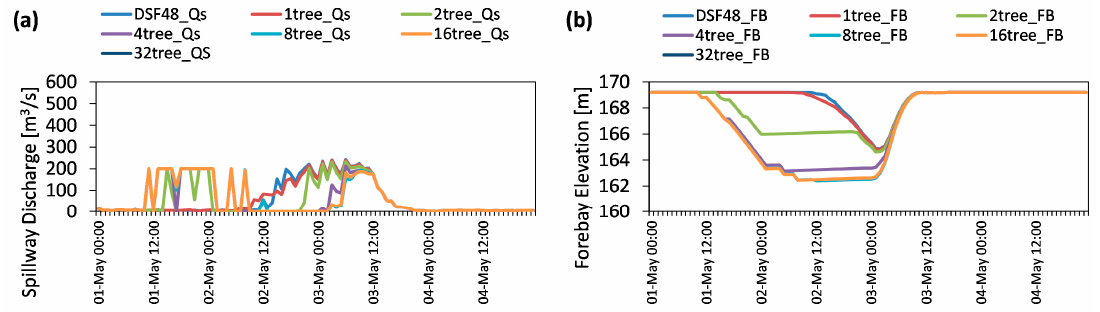
Figure 10. Comparison of closed-loop MPC with different tree reduction branches for 48 h forecast horizon (Sce-Q100a): ( a ) Spillway discharge (m 3 /s); ( b ) forebay elevation (m).